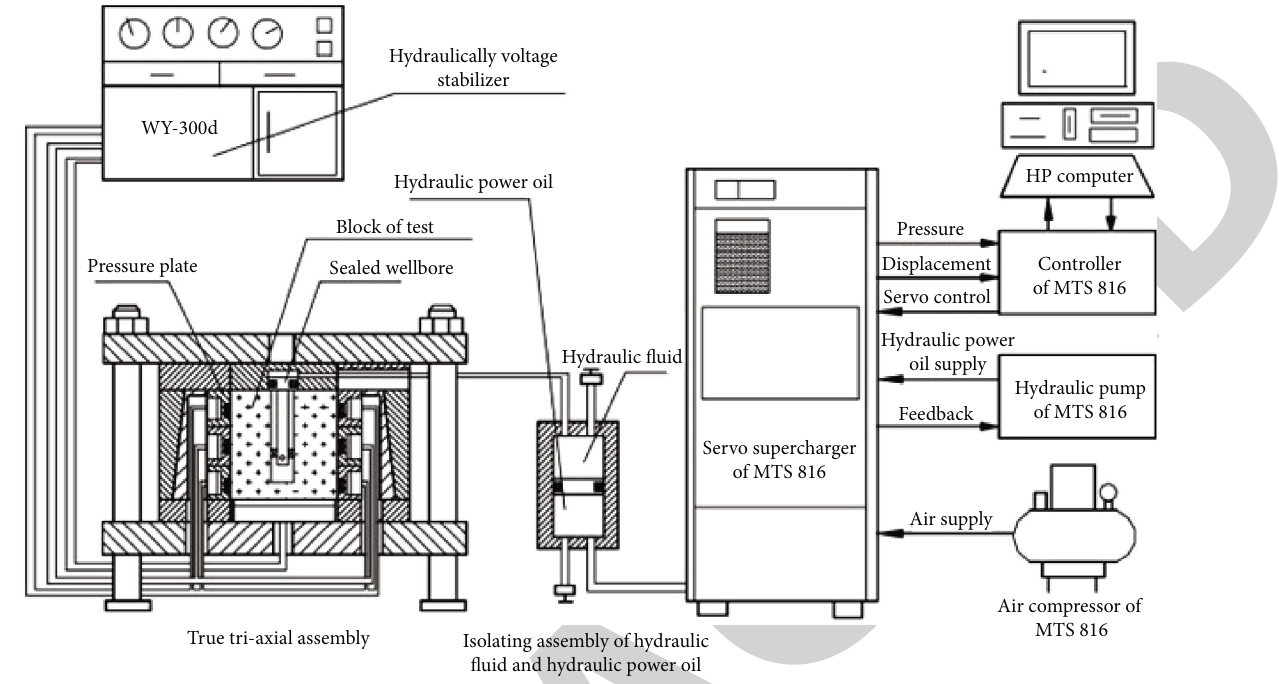
Figure 1: Schematic diagram of the triaxial hydraulic fracturing test system.